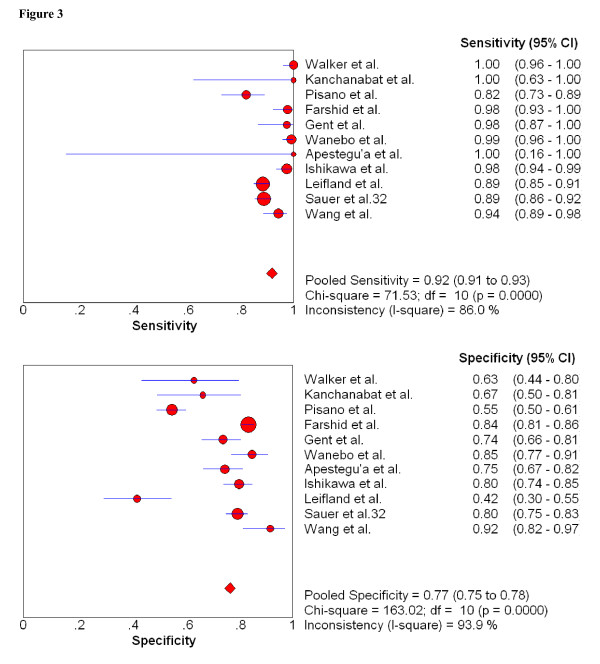
Forest plot of estimates of sensitivity and specificity for FNAB in 11 studies which reported insufficient samples. Insufficient samples considered to be positive.